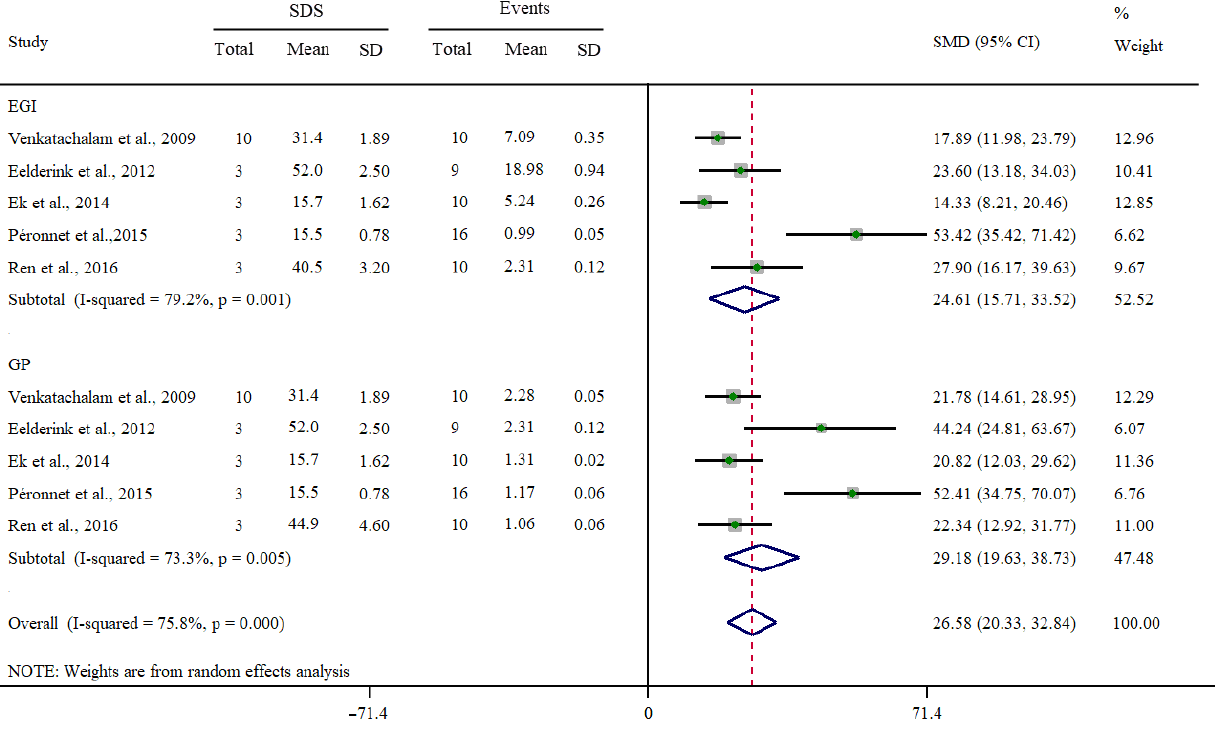
Figure 2. Forest plots of the effect of SDS intake on EGI and GP (D + L: random effect model) [10,14–17]. Each data was presented as weight (%), as well as SMD and 95% CI.